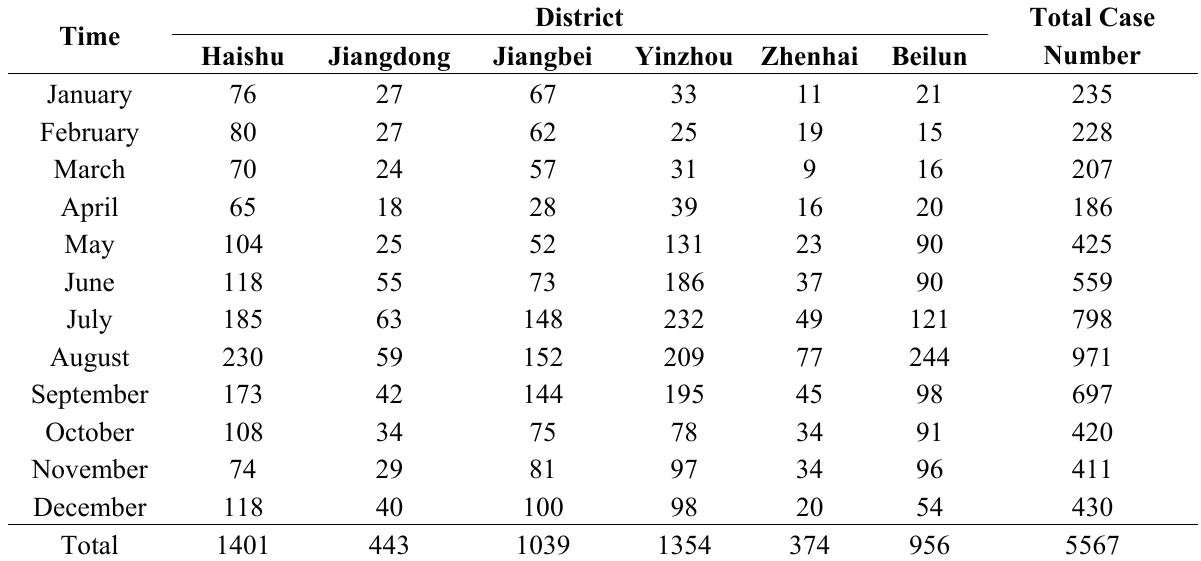
Table 4. Reported case number of the food-borne diarrhea in six districts. Time